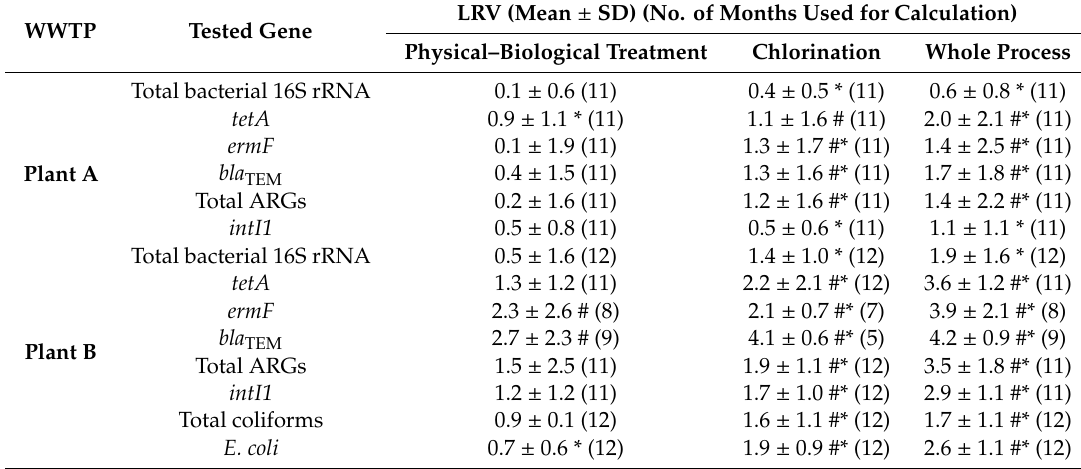
Table 2. LRVs of total bacterial 16S rRNA, ARGs, intI1 , total coliforms, and E. coli at WWTPs. LRV (Mean ± SD) (No. of Months Used for Calculation) WWTP Tested Gene Physical–Biological Treatment Chlorination Whole Process Total bacterial 16S rRNA 0.1 ± 0.6 (11)